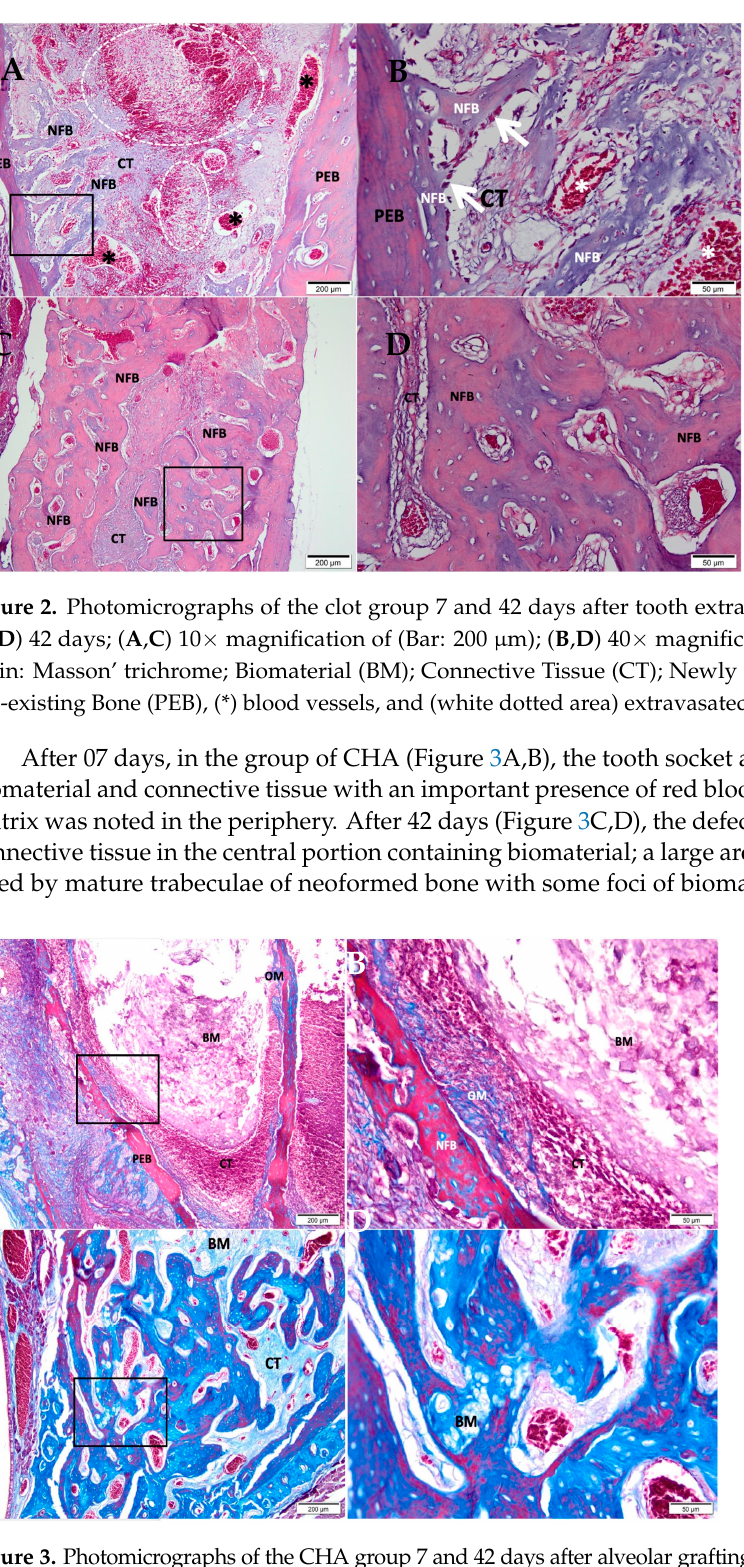
Figure 3. Photomicrographs of the CHA group 7 and 42 days after alveolar grafting. ( A , B ): 07 days; ( C , D ): 42 days; ( A , C ): 10× magnification (Bar: 200 μ m); ( B , D ): 40× magnification (Bar: 50 μ m); Stain: Masson’ trichrome. Biomaterial (BM); Connective Tissue (CT); Pre-Existing Bone (PEB); Newly Formed Bone (NFB).